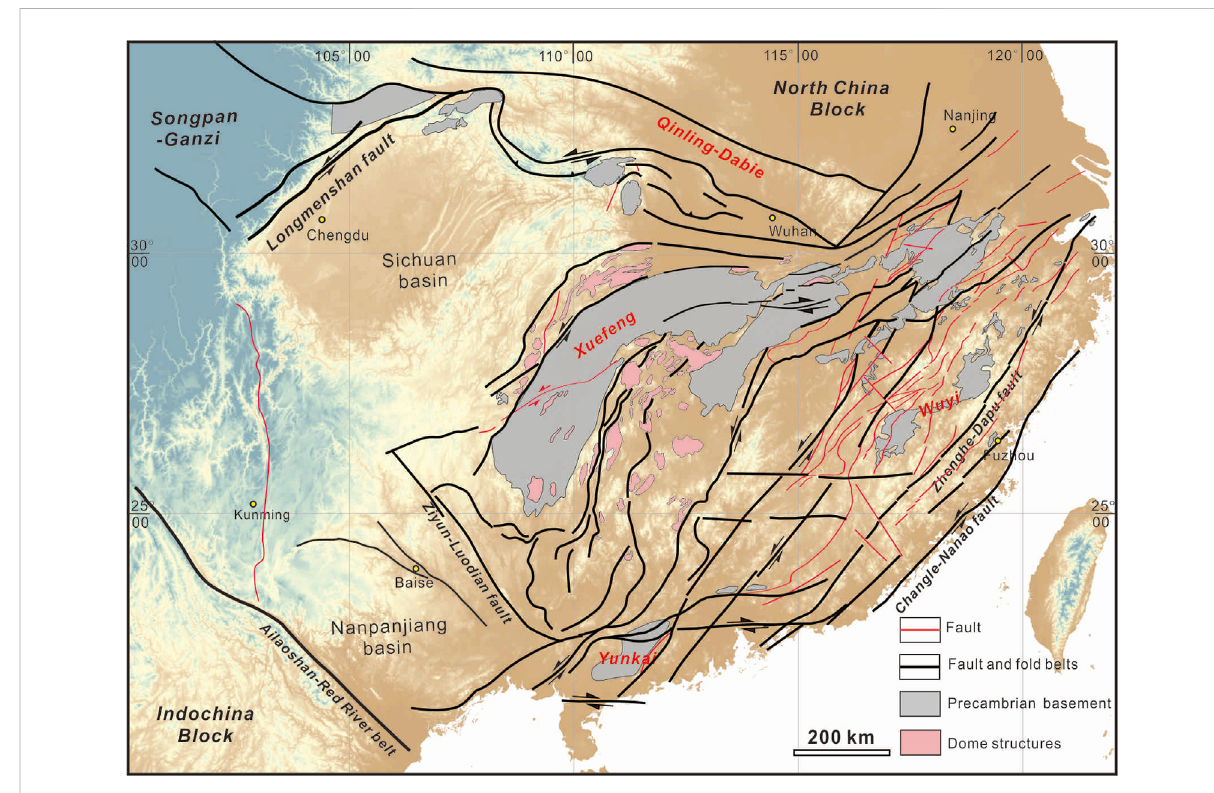
Tectonic framework of the South China Block with major fold and fault systems (after Zhang et al., 2013). The SCB was squeezed by the North China Block and Indochina Block, and subsequently affected by the Paci fi c